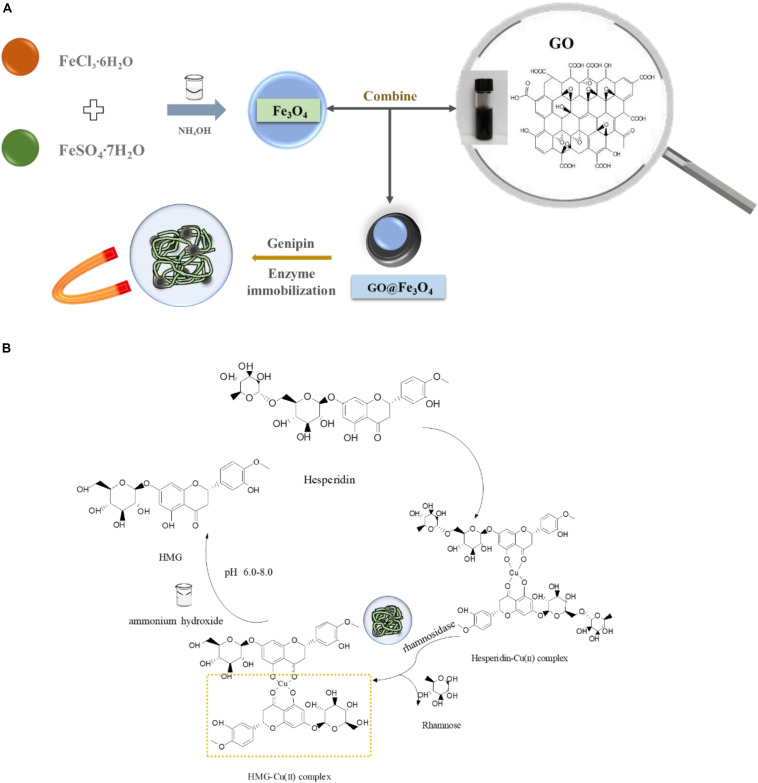
(A) Scheme of biosynthesis HMG and (B) enzyme-immobilized platform construction based on Fe3O4@GO composite.